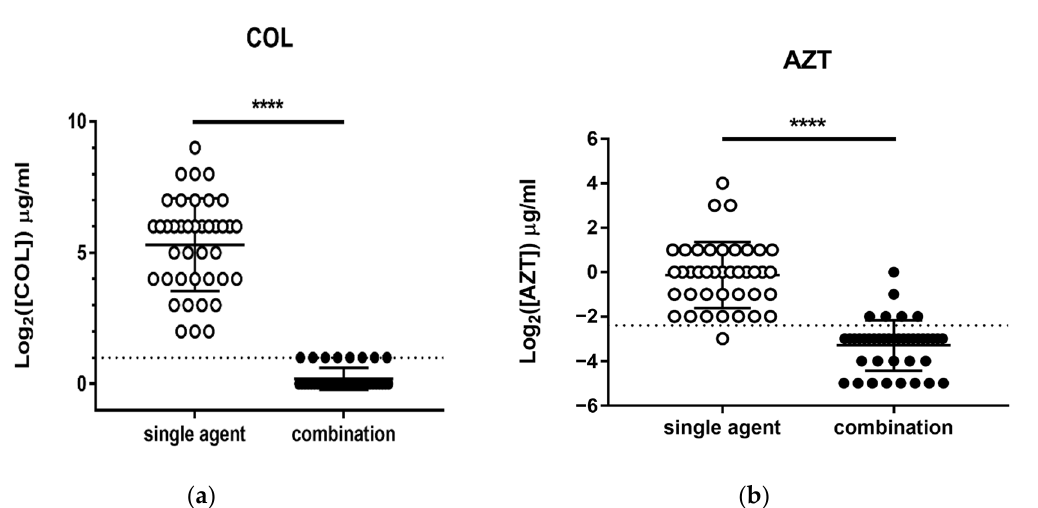
Figure 2. MIC distributions of colistin (COL, hollow circles), azidothymidine (AZT, hollow circles), and their combination (filled circles). ( a ) Dotted line indicates the breakpoint for colistin resistance according to the EUCAST guidelines. ( b ) Dotted line represents the average steady-state concentration of AZT in plasma (0.19 μg/mL). ****, p < 0.0001 with the paired t -test.